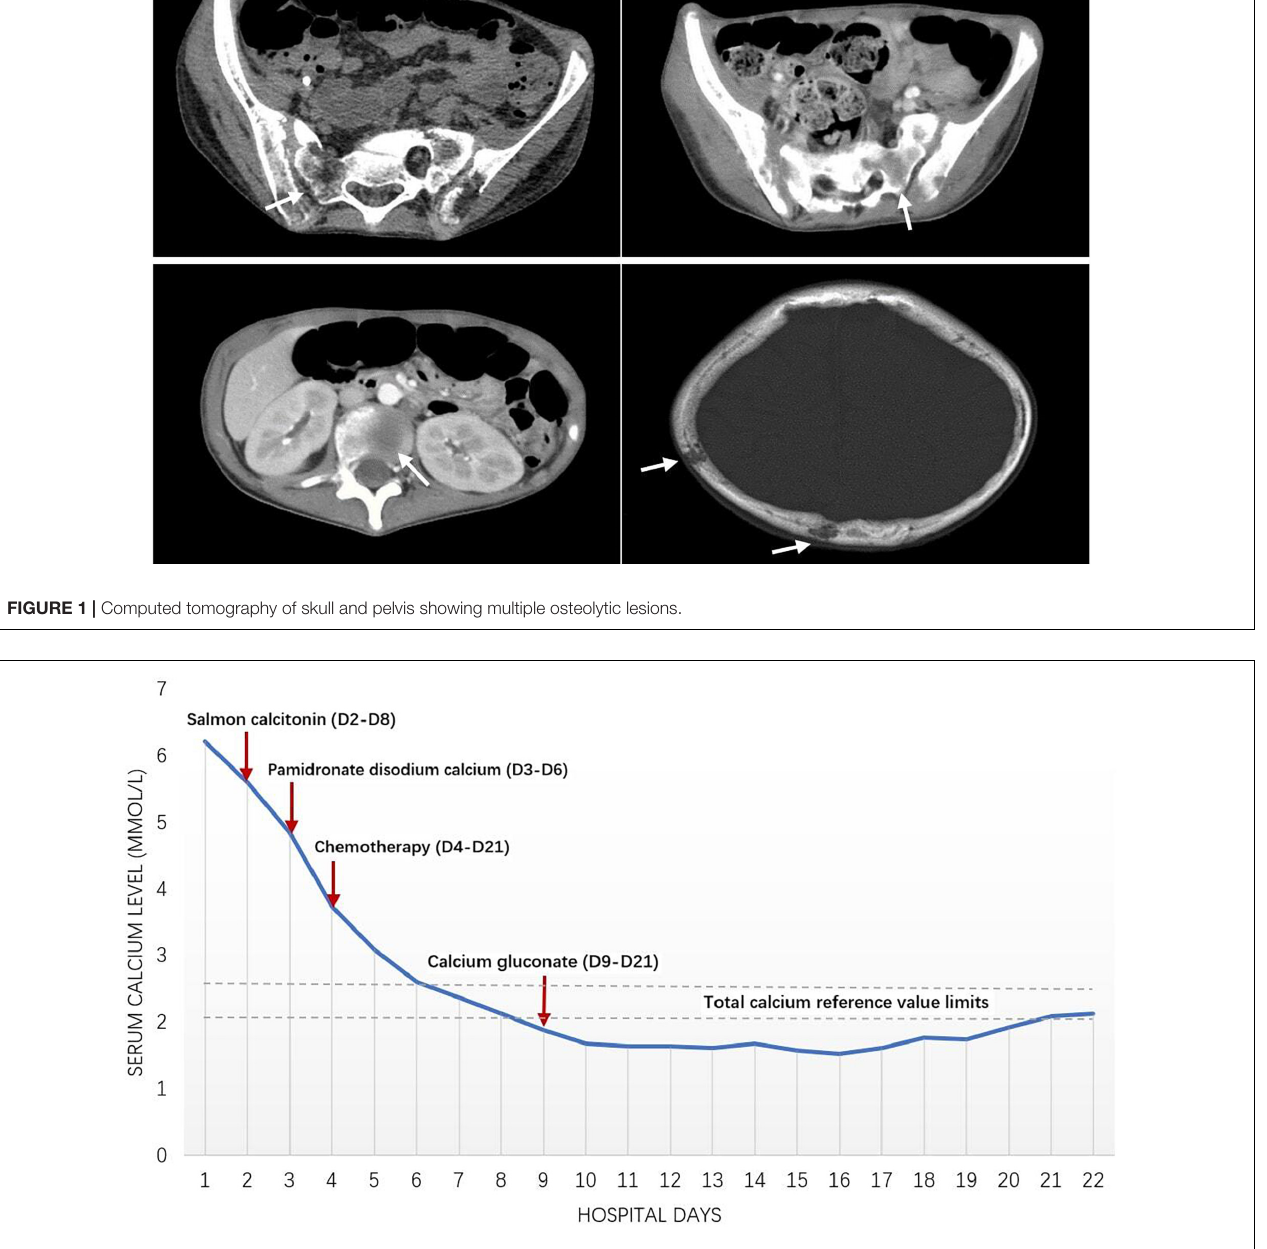
FIGURE 2 | Clinical courses; changes of serum calcium